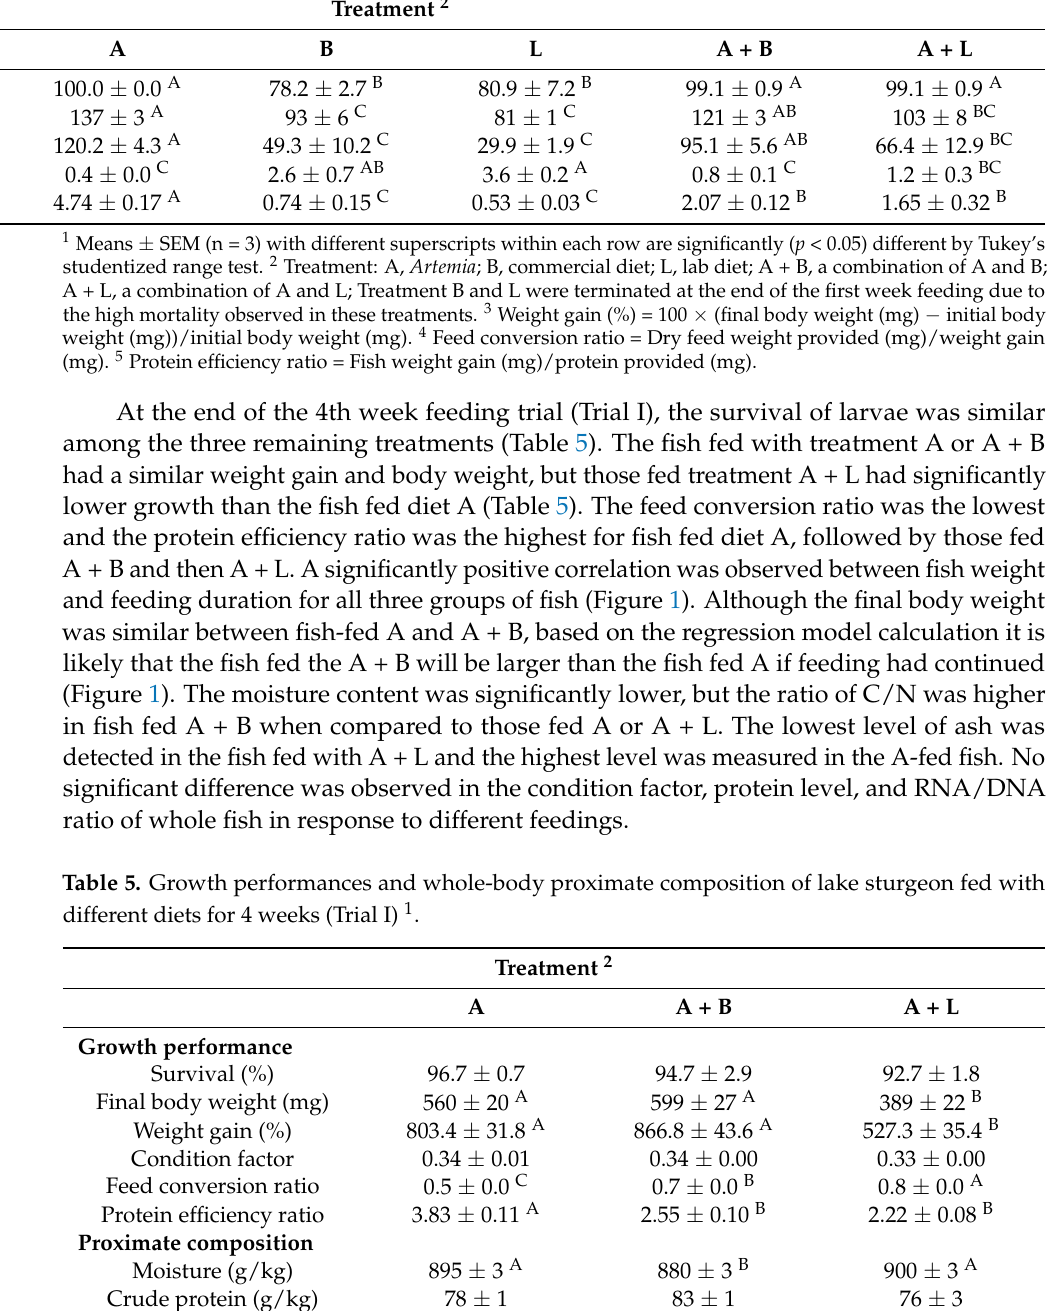
Table 4. Growth performances of lake sturgeon larvae fed the different diets for one week (Trial I) 1 . Treatment 2